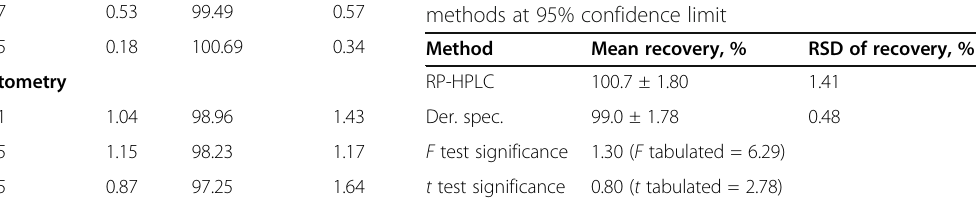
Table 6 Statistical analysis of results obtained by the